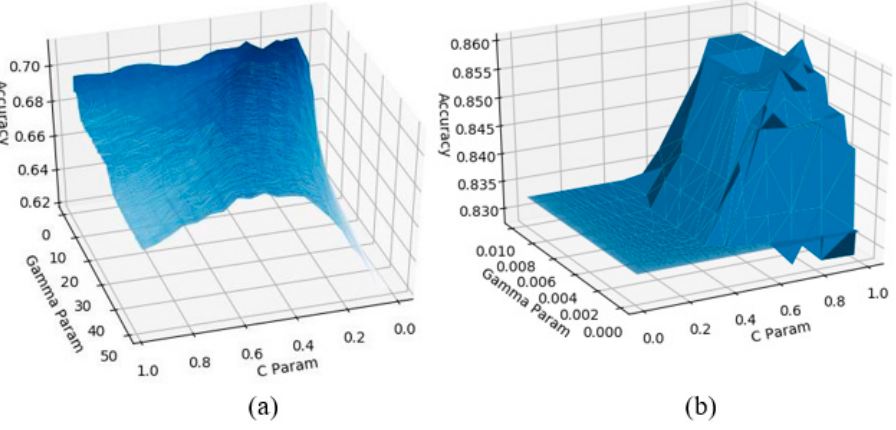
Figure 7. Hyperparameters optimization for the ( a ) SVM model and ( b ) for the GA-SVM model.